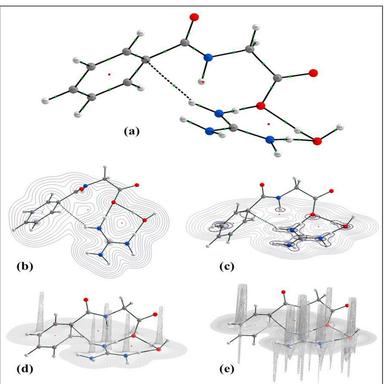
(a) BCPs (green dots on the line connecting two atoms) and RCPs (red dots inside closed paths) of GuHM (b) Contour plot of charge density ρ (c) Contour plot of Laplacian of ρ (d) Relief map of ρ (e) Relief map of Laplacian of ρ. (For interpretation of the references to colour in this figure legend, the reader is referred to the Web version of this article.)